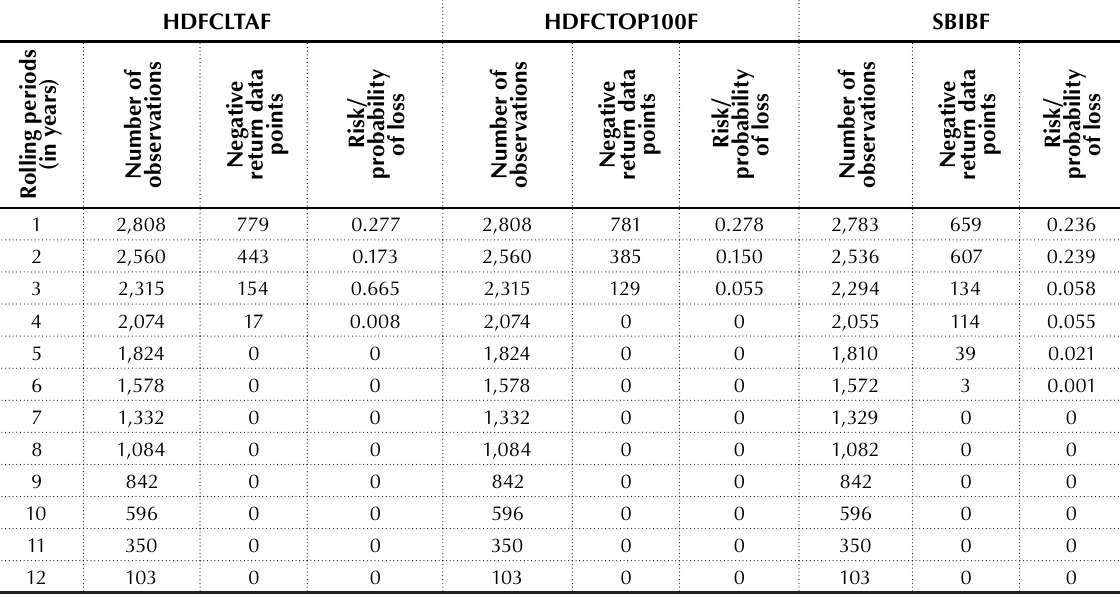
Table 18. Rolling period risk and return behavior of HDFCLTAF, HDFCTOP100F and SBIBF (2006–2018)